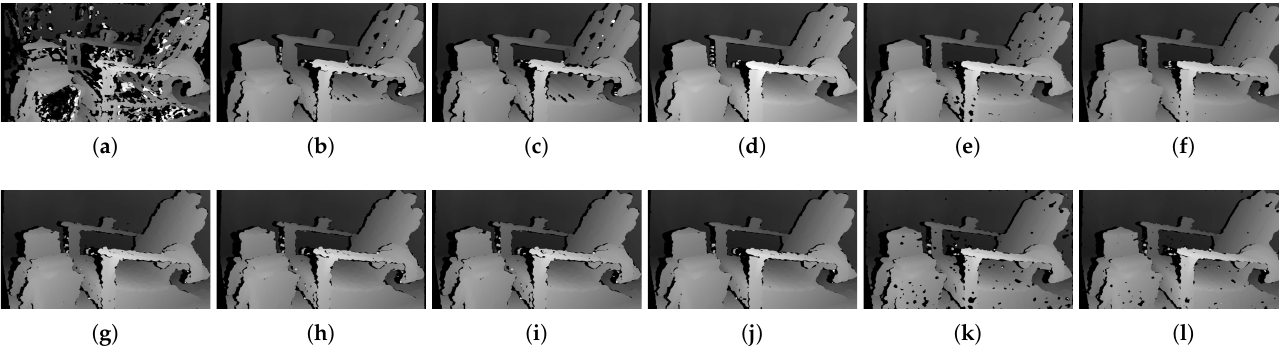
Figure 14. Estimated disparity images of the combinations of cost and image filter using the window- based stereo method, according to the low and high pattern contrast parameters. The images in the top row show disparities at low contrast, and the images in the bottom row show those at high contrast, respectively. ( a ) Window, SAD. ( b ) Window, Mean/SAD. ( c ) Window, LoG/SAD. ( d ) Win- dow, BilSub/SAD. ( e ) Window, Rank/SAD. ( f ) Window, Census. ( g ) Window, SAD. ( h ) Window, Mean/SAD. ( i ) Window, LoG/SAD. ( j ) Window, BilSub/SAD. ( k ) Window, Rank/SAD. ( l ) Win- dow,